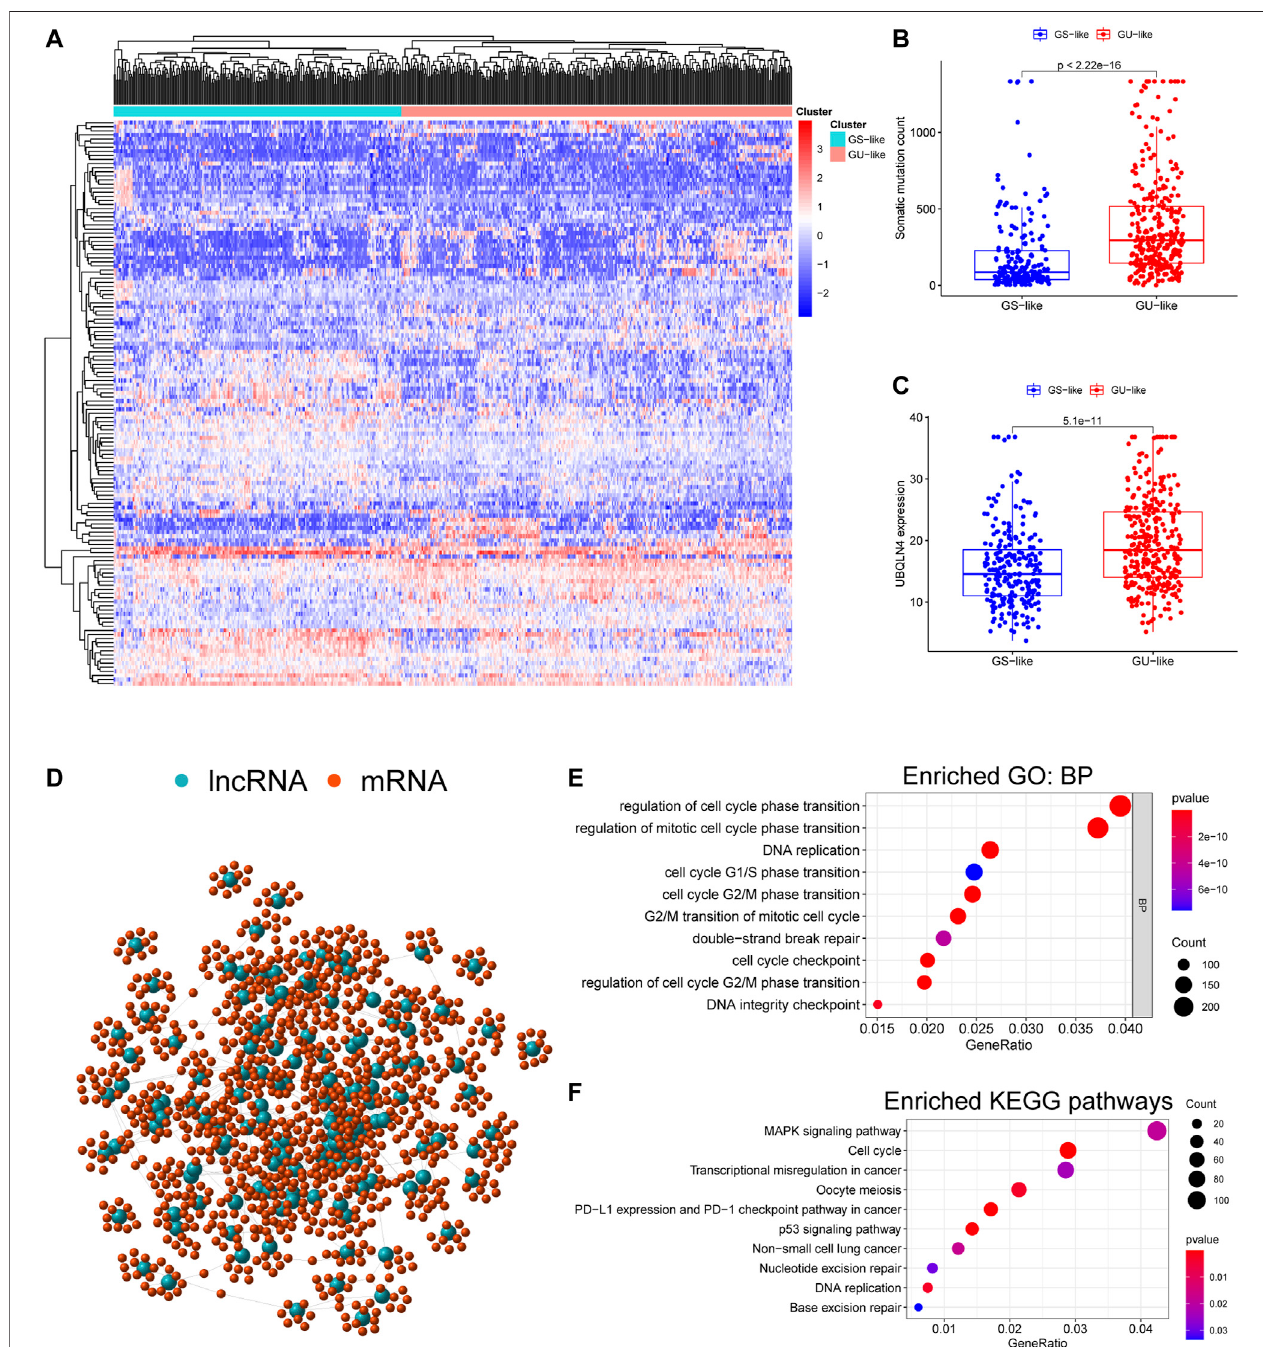
FIGURE 2 | Functional annotation of GI-lncRNAs in LUAC patients. (A) Hierarchical clustering analysis of differentially expressed lncRNAs in the two clusters: GS- like cluster and GU-like cluster; (B) Somatic mutation counts inthe GS-like clusterand GU-likecluster; (C) Comparison ofexpression levels ofUBQLN4, adriver geneof GI, between the GS-like cluster and the GU-like cluster; (D) Network analysis of the relationship between GI-lncRNAs and mRNAs; (E) GO analysis; (F) KEGG pathway analysis.